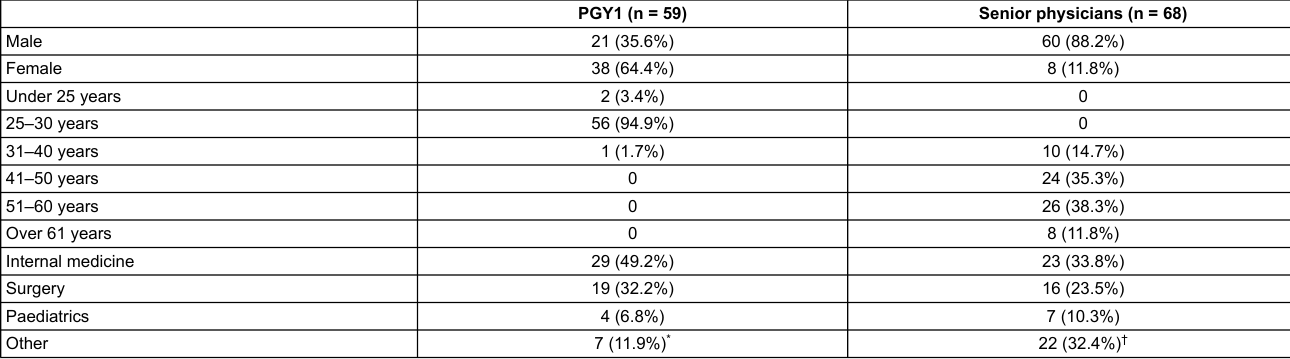
Table 1: Demographics of first-year postgraduate (PGY1) residents and senior